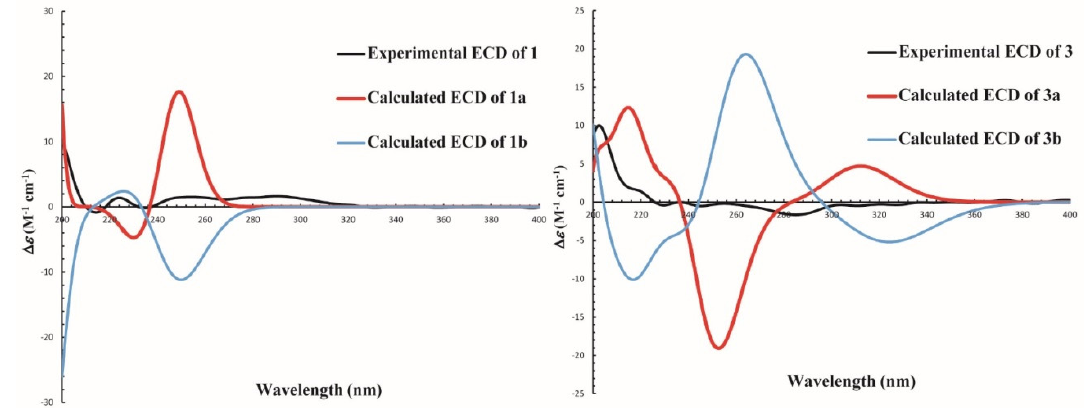
Figure 3. Experimental ECD and calculated ECD spectra of compounds 1 and 3 in CH 3 OH.